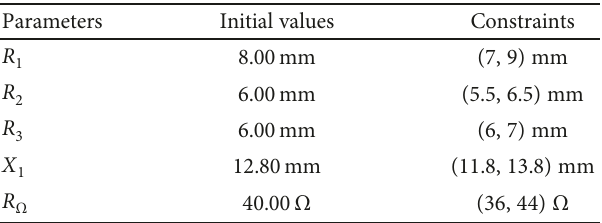
Table 2: The initial values of each parameter.